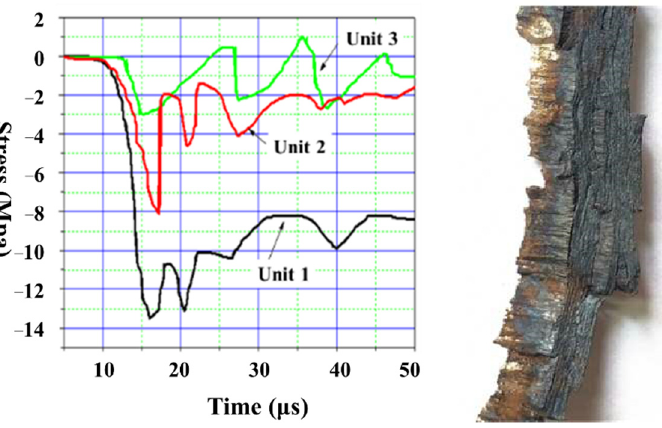
Figure 12. The time − history curves of radial stress of three point and experimental fracture4. Dynamic Fracture Analysis of Cylindrical Shells.